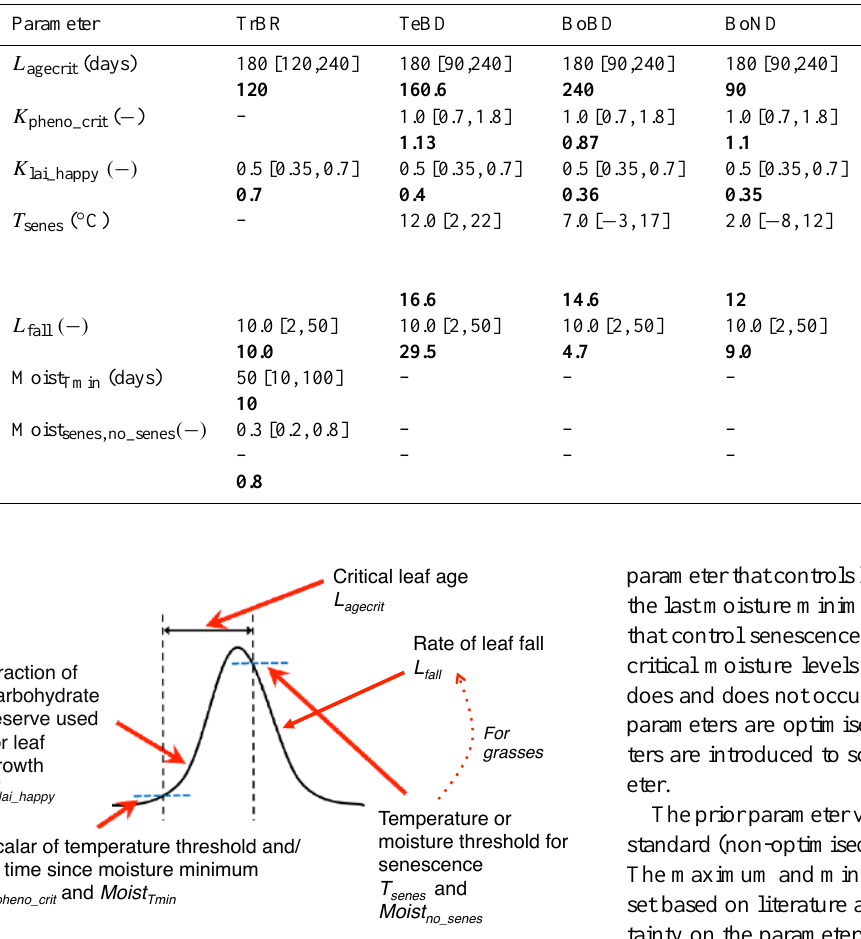
Figure 1. Schematic to show how the optimised parameters control the timing of the leaf phenology in ORCHIDEE. The dotted arrow shows that the temperature and moisture threshold for senescence also affects the rate of leaf fall for grasses by slowing down the turnover rate once this threshold has been reached (whereas for trees only the L fall parameter is